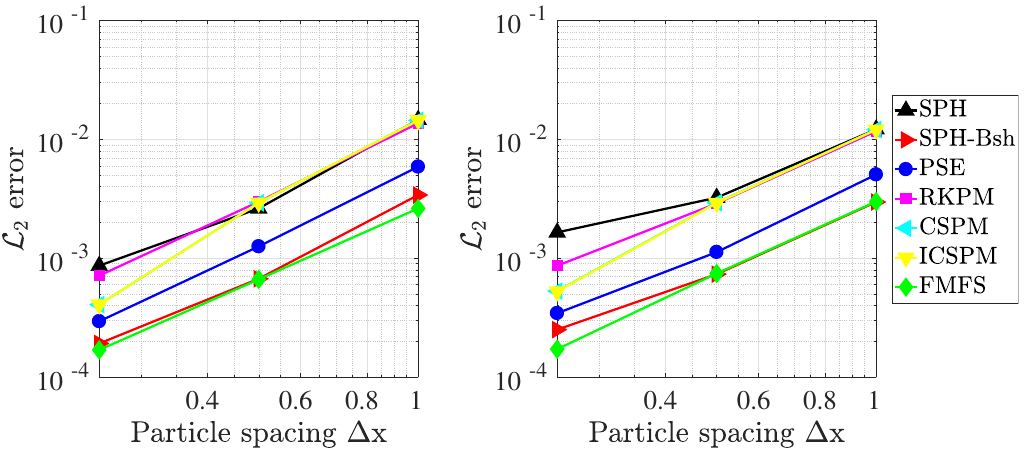
Figure 4. Convergence plots of the particle methods in a 3D heat conduction test. Left: regular spacing. Right: random spacing. The cubic B-spline kernel with h = 1.5 (cid:52) x is used.